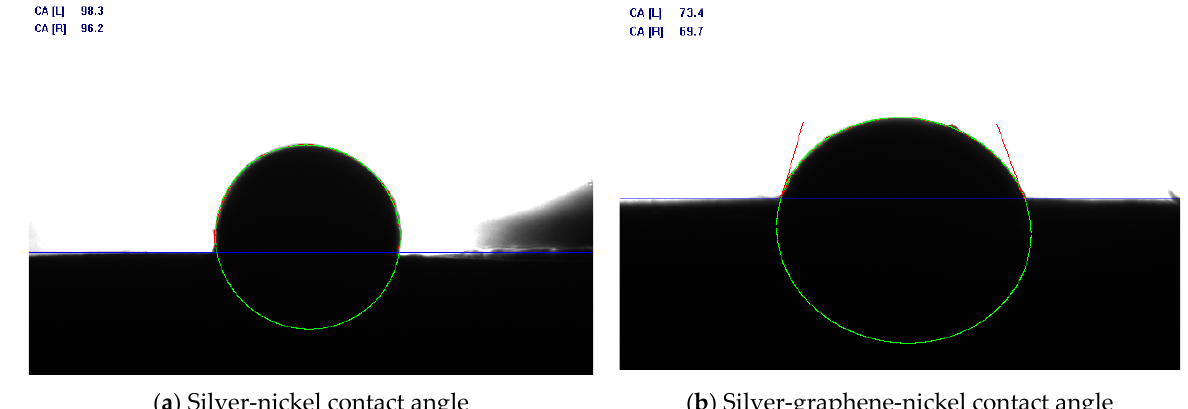
Figure 3. Silver-nickel contact angle before and after graphene addition.